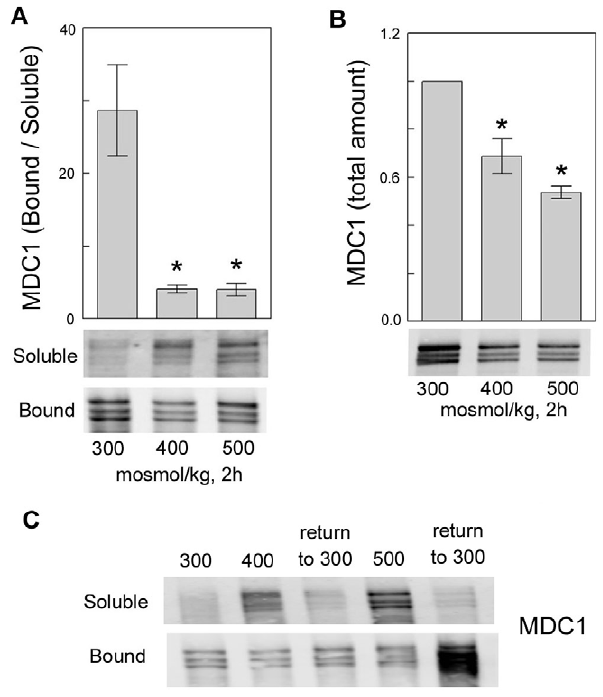
Figure 3. Effect of high NaCl on MDC1 abundance and distribution. HEK293 cells were exposed to media of the indicated total osmolalities (NaCl varied) for 2 h. A. High NaCl increases the abundance of MDC1 in the soluble fraction and decreases it in the chromatin-bound fraction. (n=3, *P , 0.05, t test). B. High NaCl decreases total MDC1 abundance (n=3, *P , 0.05, t test). C. After 2 h of exposure to high NaCl medium osmolality was decreased to 300 mosmol/kg for 30 min. MDC1 returns to the chromatin-bound fraction within that time (representative of 2 experiments).